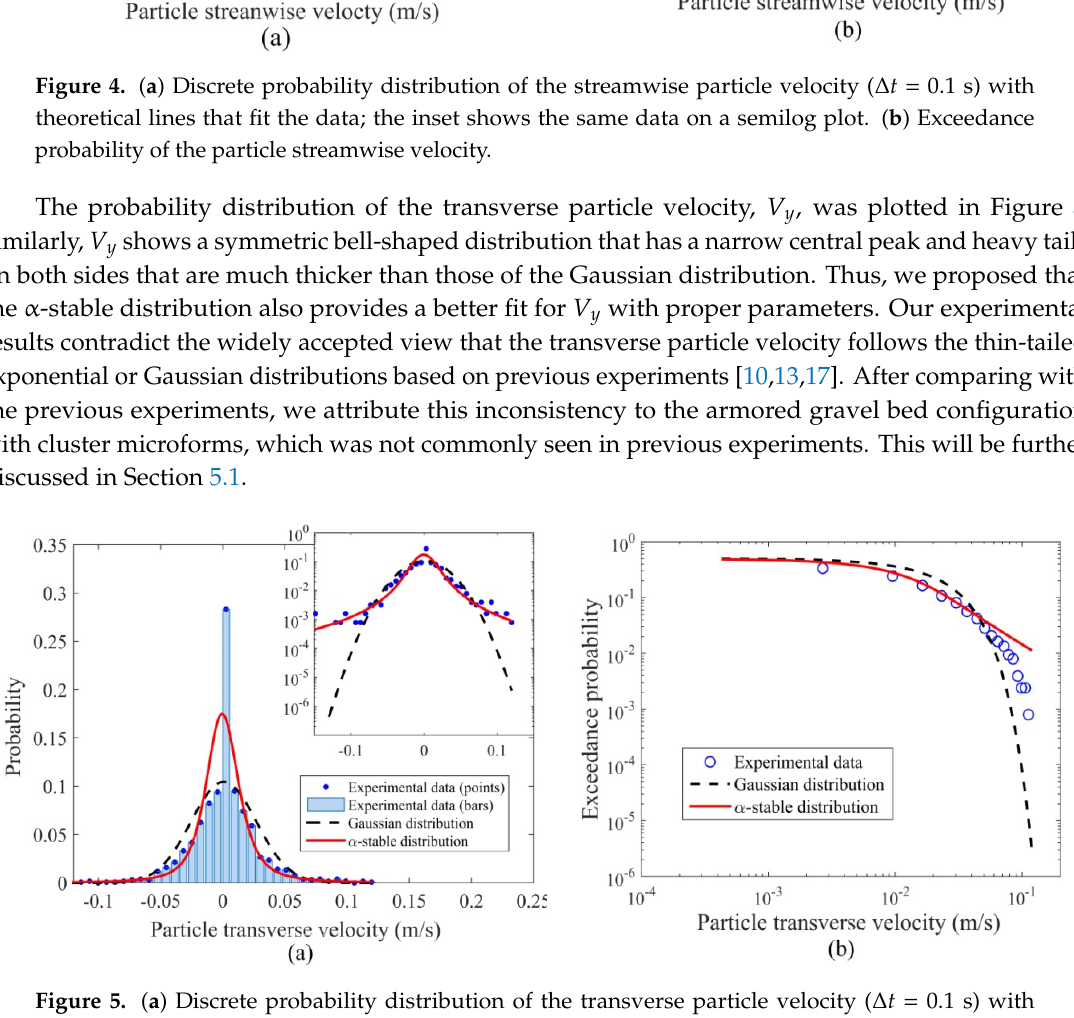
Figure 4. ( a ) Discrete probability distribution of the streamwise particle velocity ( ∆ t = 0.1 s) with theoretical lines that fit the data; the inset shows the same data on a semilog plot. ( b ) Exceedance probability of the particle streamwise velocity.